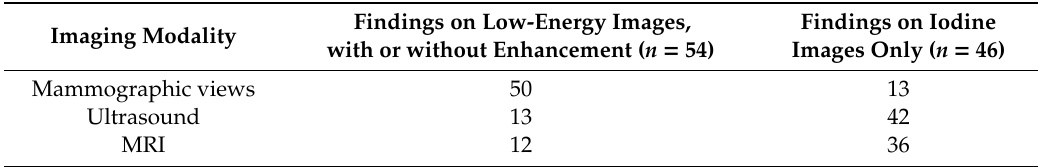
Table 1. Additional imaging evaluation of findings seen on a low-energy mammography (with or without enhancement) versus on iodine images only.